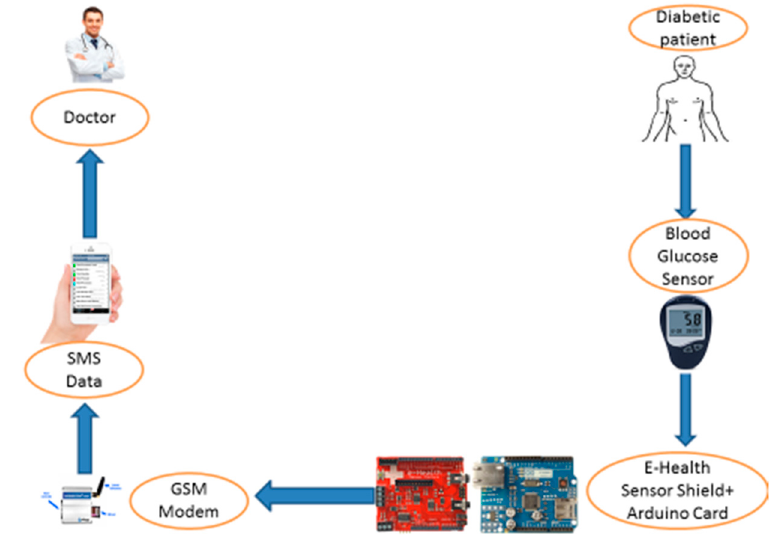
Figure 5. Flow chart of the system.